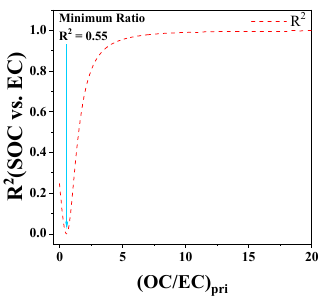
Figure 3. Relationship between the correlation coefficient R 2 of SOC and EC and the assumed (OC/EC) pri .